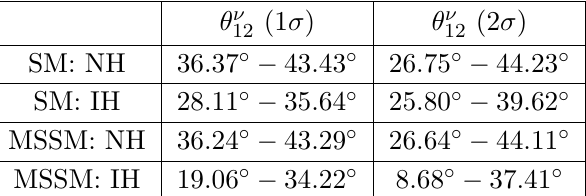
which predict the correct experimental value for 12